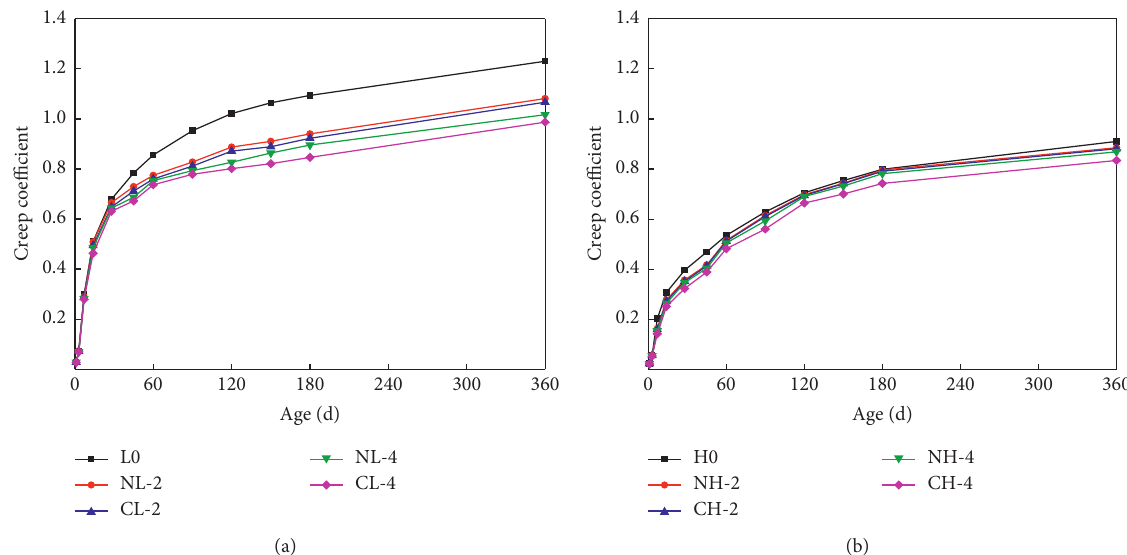
Figure 19: Creep coefficient of concrete at different ages. (a) C30. (b) C50.